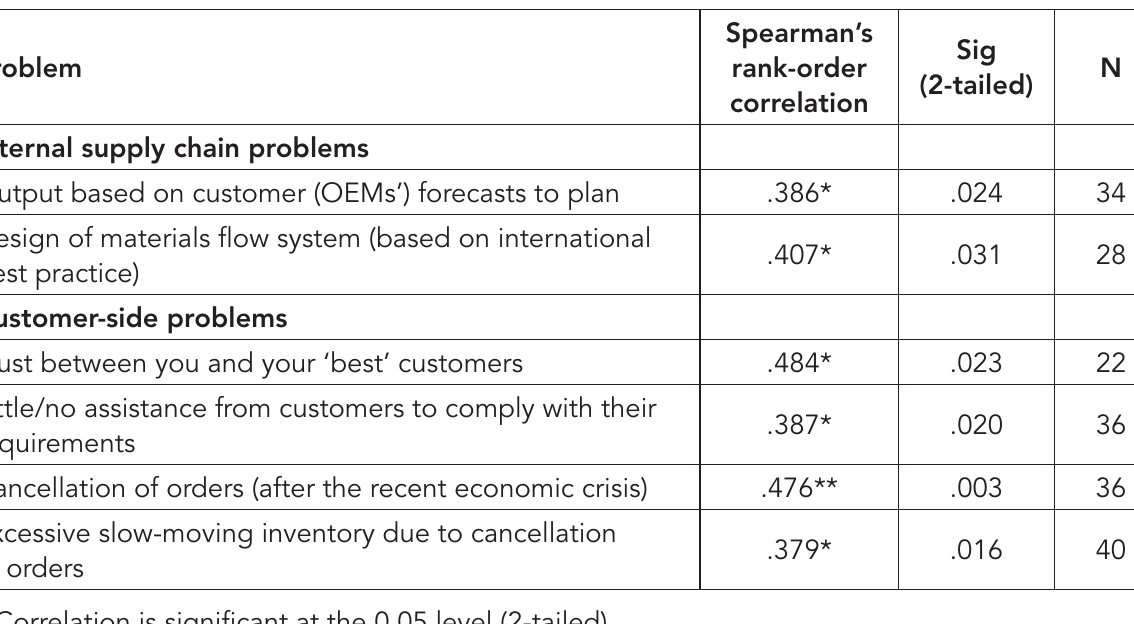
Table 6: Significant correlation between on-time